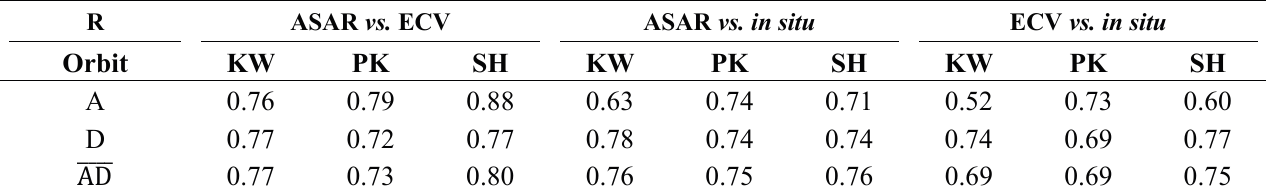
Table 4. Unbiased RMSD evaluated for each soil moisture dataset comparison. ubRMSD unbiased RMSD. ubRMSD ASAR vs. ECV ASAR vs. in situ ECV vs. in situ